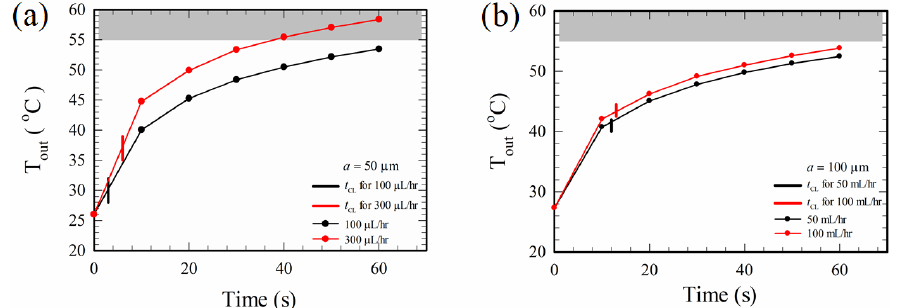
Figure 8. Variations of outlet temperatures, T out , with time for di ff erent flow rates and channel widths: ( a ) a = 50 µ m, and ( b ) a = 100 µ m. The vertical short line intersecting each curve marks the time for complete cell lysis of the corresponding case. The grey region for temperature greater than 55 ◦ C is the region for thermal lysis of red blood cells.